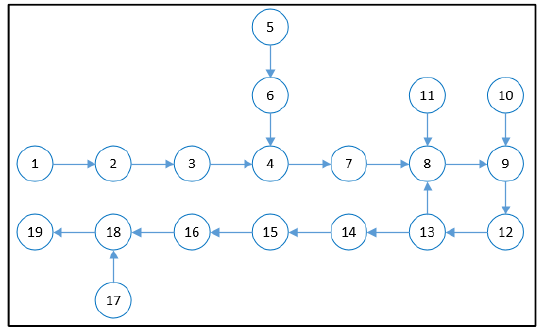
Figure 7. Procedures digraph model.